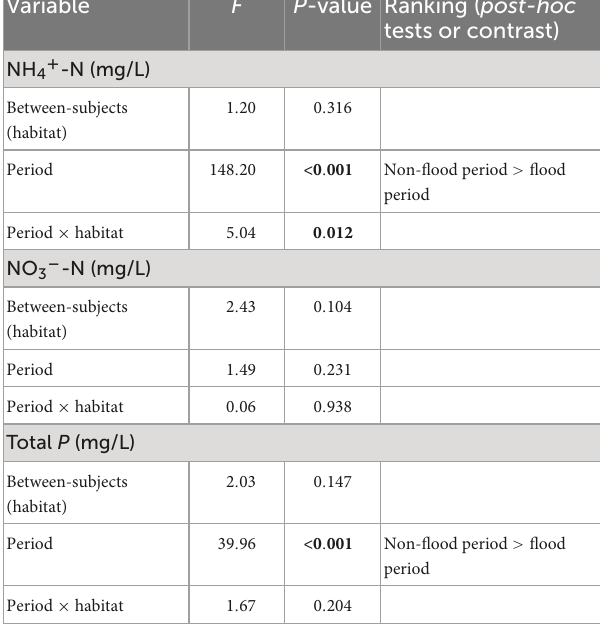
TABLE 1 Repeated-measured ANOVA results of water environmental variables in three different habitats of the White River Basin across two hydrological